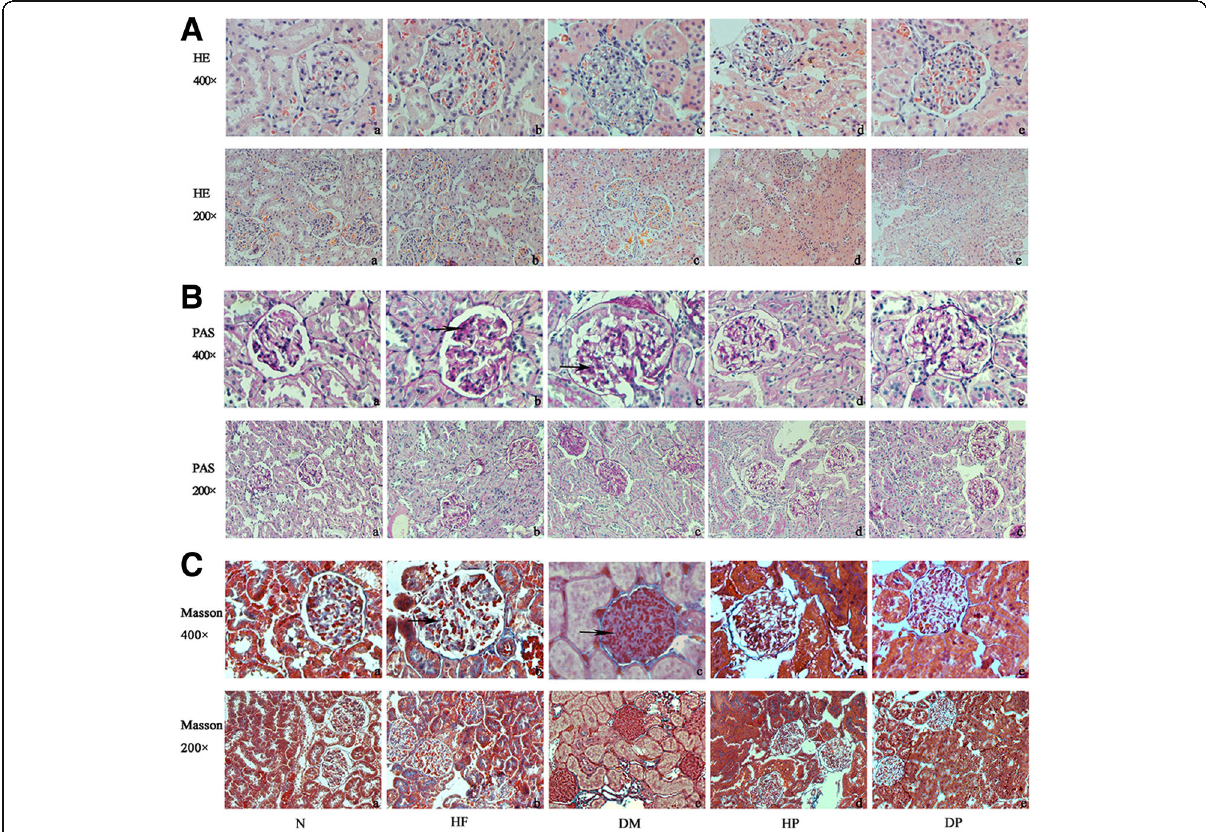
Fig. 3 Renal pathology of experimental rats. Representative pictures of H + E, PAS, and masson trichrome staining are presented as a to c , respectively. Picture a represents the normal group, picture b represents the HF group, picture c represents the DM group, picture d represents the DP group, picture e represents the HP